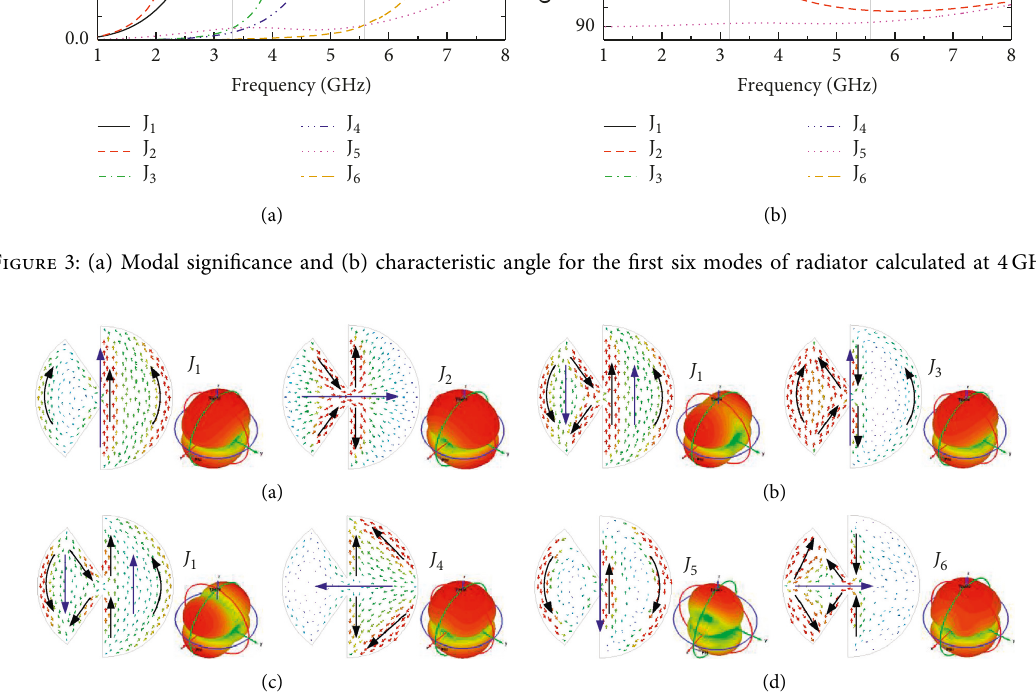
1 and J 2 at 3.3 GHz. (b) Modes J 1 and J 3 at 4.6GHz. (c) Modes